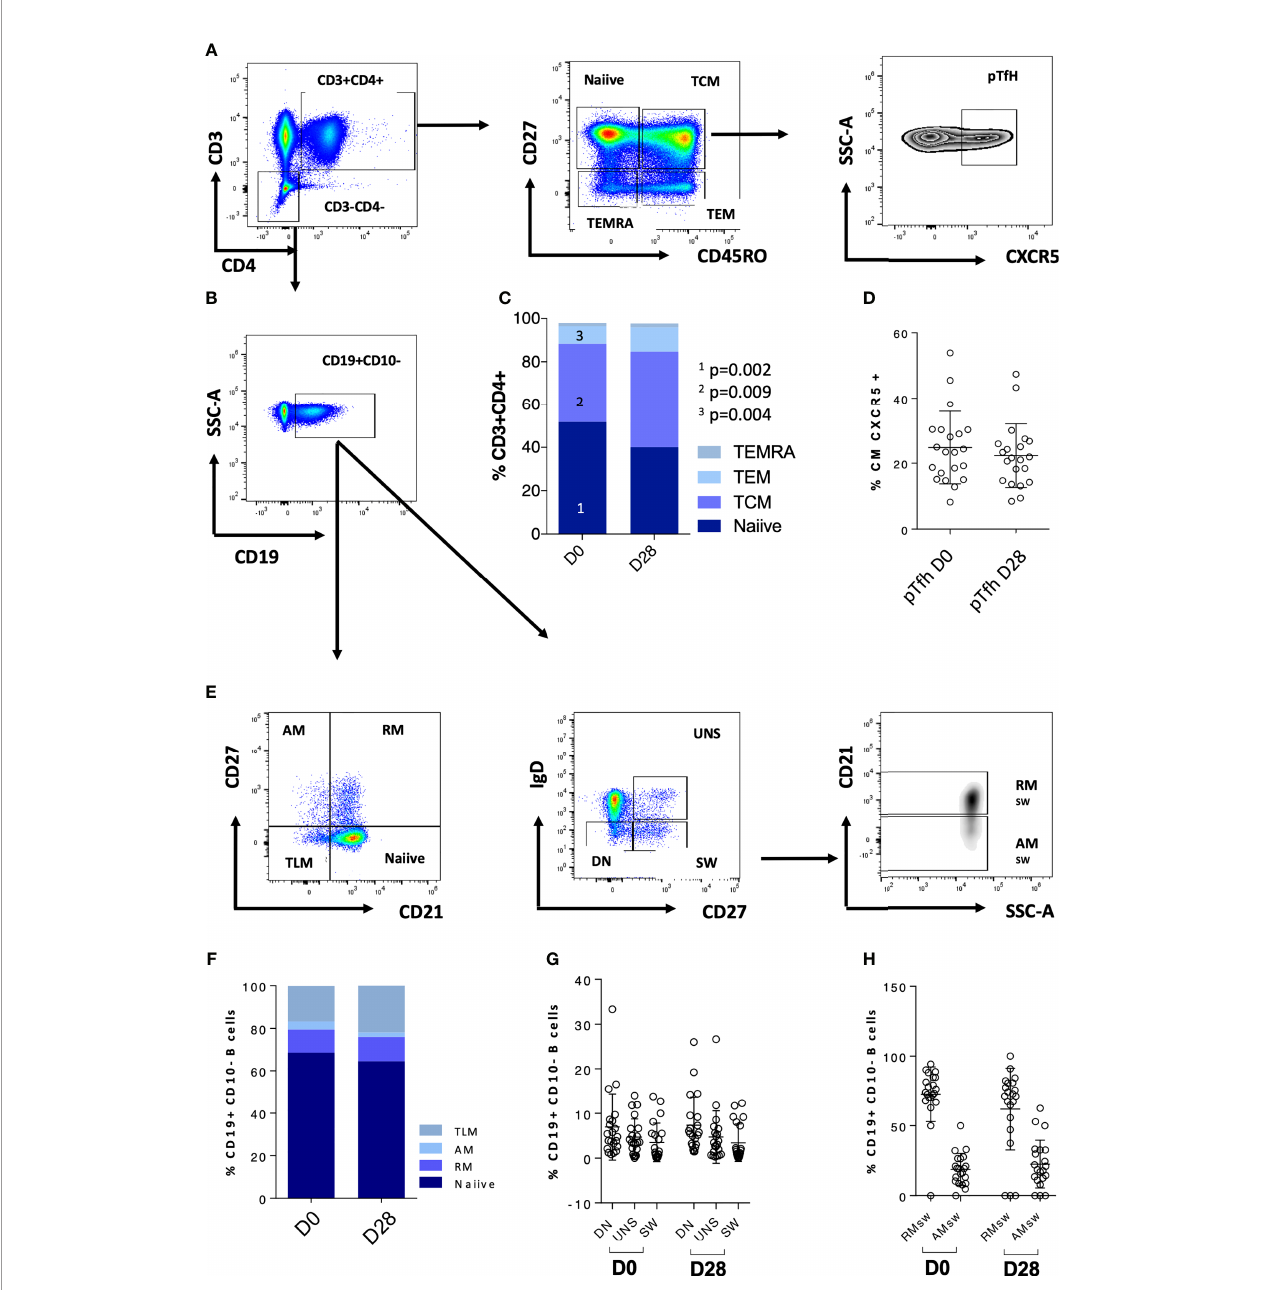
FIGURE 3 | CD4T-cell and B-cellphenotypecharacteristics of the wholecohort are reported. (A) Gating strategyfor CD4T-cellpopulations; (B) gating strategy for the CD19+ population used to analyze the B-cellsubsets. (C) CD4 T-cellpopulationsat D0and D28; (D) pTfhat D0and D28. (E) Gating strategy for the B-cellpopulations. (F – H) B-cellpopulationsat D0andD28. Non-pairednon-parametric Mann – Whitney testwas usedto assess differences inthe levelsof each sub-population in (C,D, F – H) . TCM, central memory T cells; TEMRA, terminally differentiatedT cells; TEM,effector memory; pTfh, peripheral follicular T cells; TLM, tissue-like memory; AM, activated memory; RM, resting memory; UNS, unswitched;DN, doublenegative; SW, switched; RM sw , resting memoryswitched B cells; AM sw , activated memory switched B